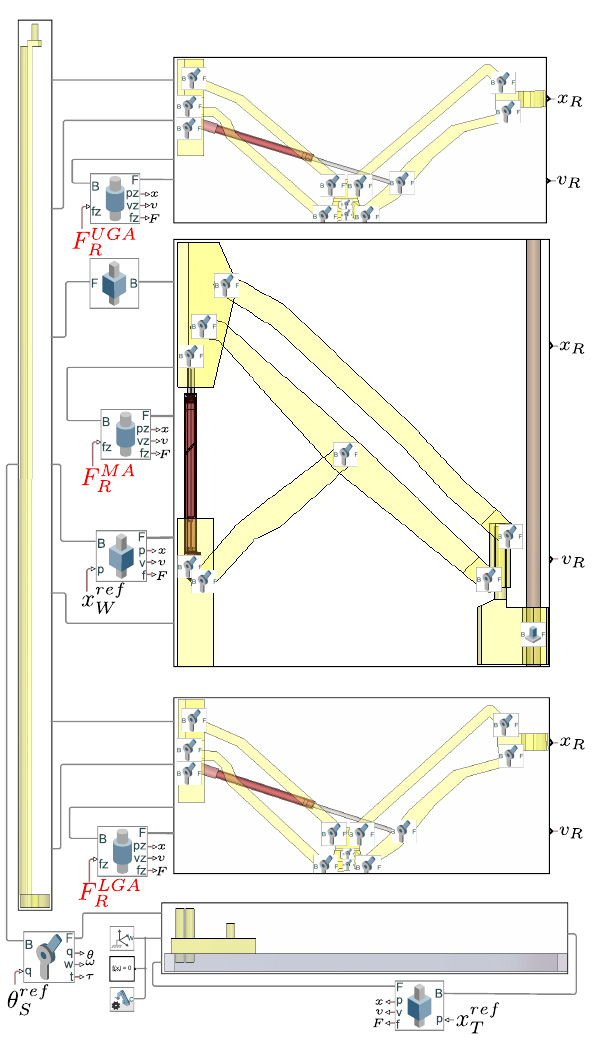
Figure 7: The MATLAB-Simulink R (cid:13) MBS